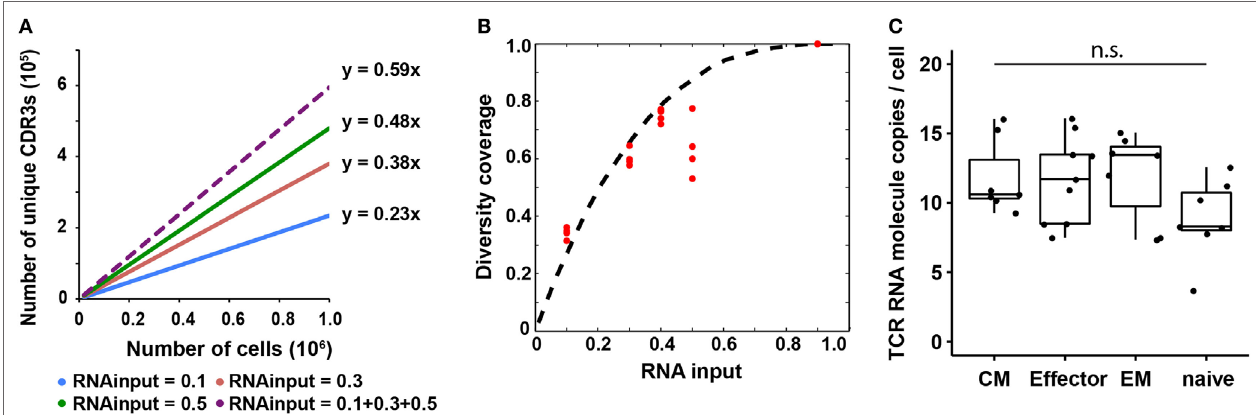
FIGURe 3 | T cell receptor (TCR) RNA copy number per cell estimation and experimental validation. (A) Diversity coverage of unique productive complementarity- determining regions 3 with different RNA inputs and cell numbers (Line represents linear regression fit, F -test on the slope, R 2 > 0.99 and p < 10 − 3 for all different RNA inputs). (B) Diversity coverages with different RNA inputs using 3 as a predicted TCR RNA molecule copy number per cell. Dashed line is the theoretical prediction (see Materials and Methods); red dots are diversity coverages observed in libraries with different RNA inputs as illustrated in panel (A) , assuming diversity coverage at 90% RNA input is 1. (C) Digital PCR results of TCR RNA molecule copies per cell in different CD8 + T cell subset (N, naïve; CM, central memory; EM, effector memory; E, effector; NTC, no template control; n.s: p -value > 0.05 by Mann–Whitney U